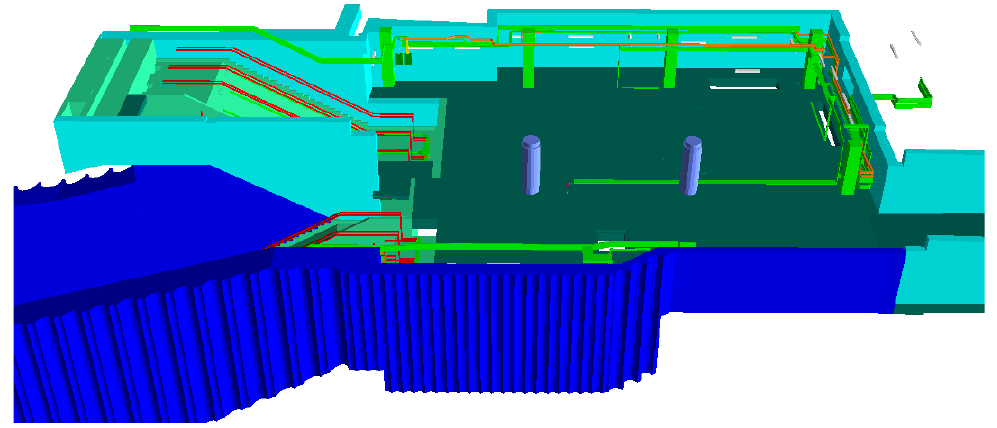
Figure 6. Station ticket hall showing structural, architectural and MEP objects in ESRI